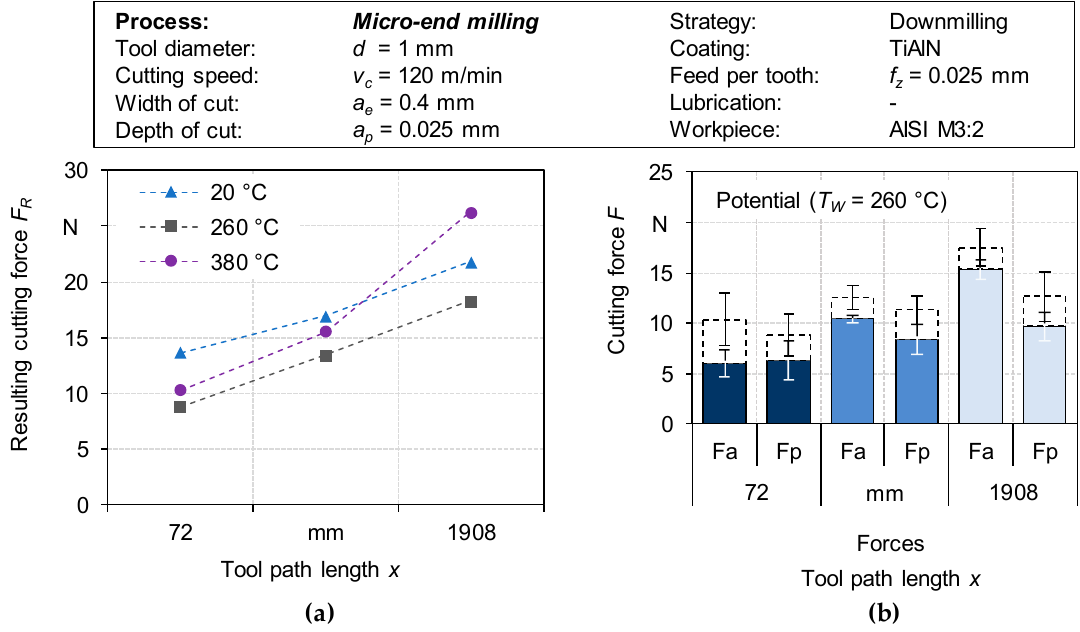
Figure 2. ( a ) Resulting cutting force F R ; ( b ) detailed components of the cutting force, comparing F R ,260 °C and F R, 20 °C to show the potential.